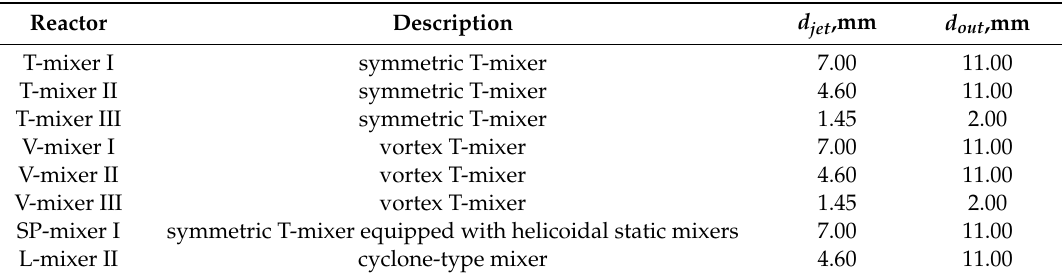
Figure 3. Geometry of: ( a ) a symmetric T-mixer equipped with helicoidal static mixers (SP-mixer I); ( b ) a cyclone-type mixer (L-mixer II). Table 1. Dimensions of the studied